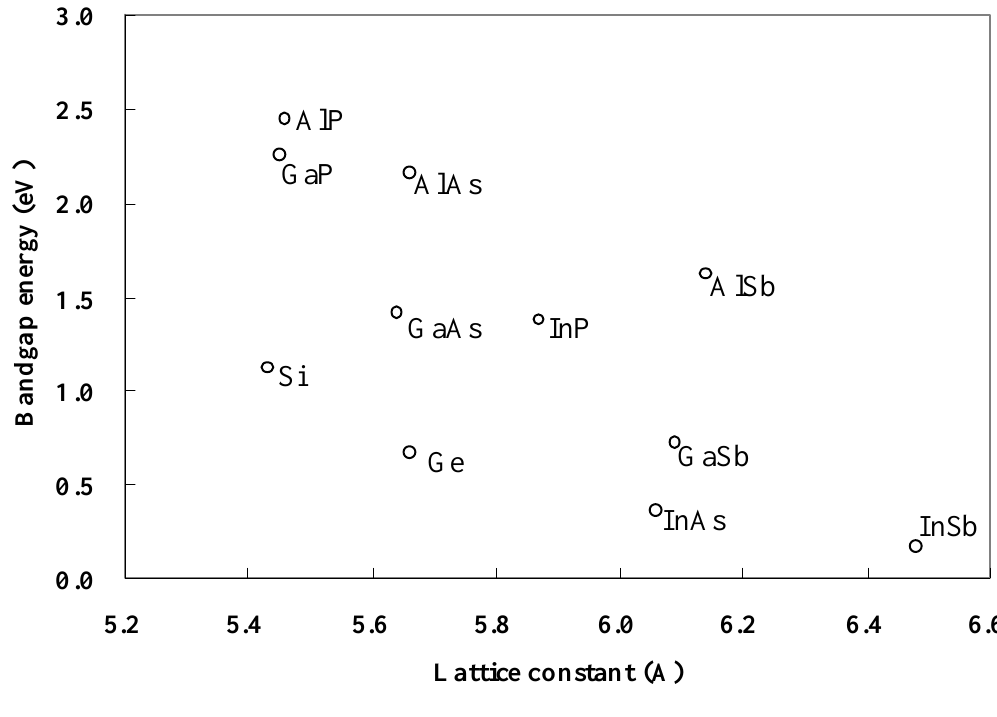
Figure 6. Bandgap energies plotted as a function of the lattice constant of semiconductors.